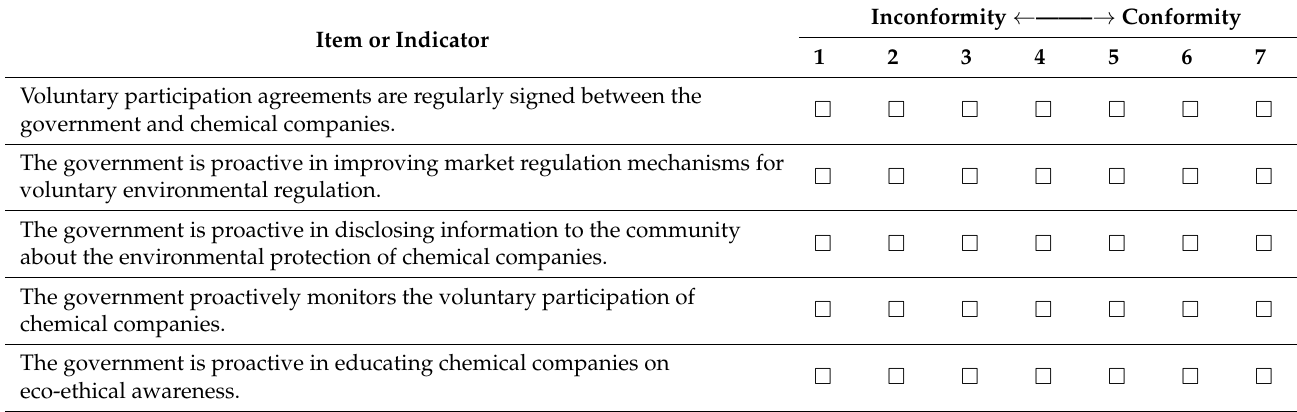
Table A4. Questionnaire for voluntary environmental regulation.